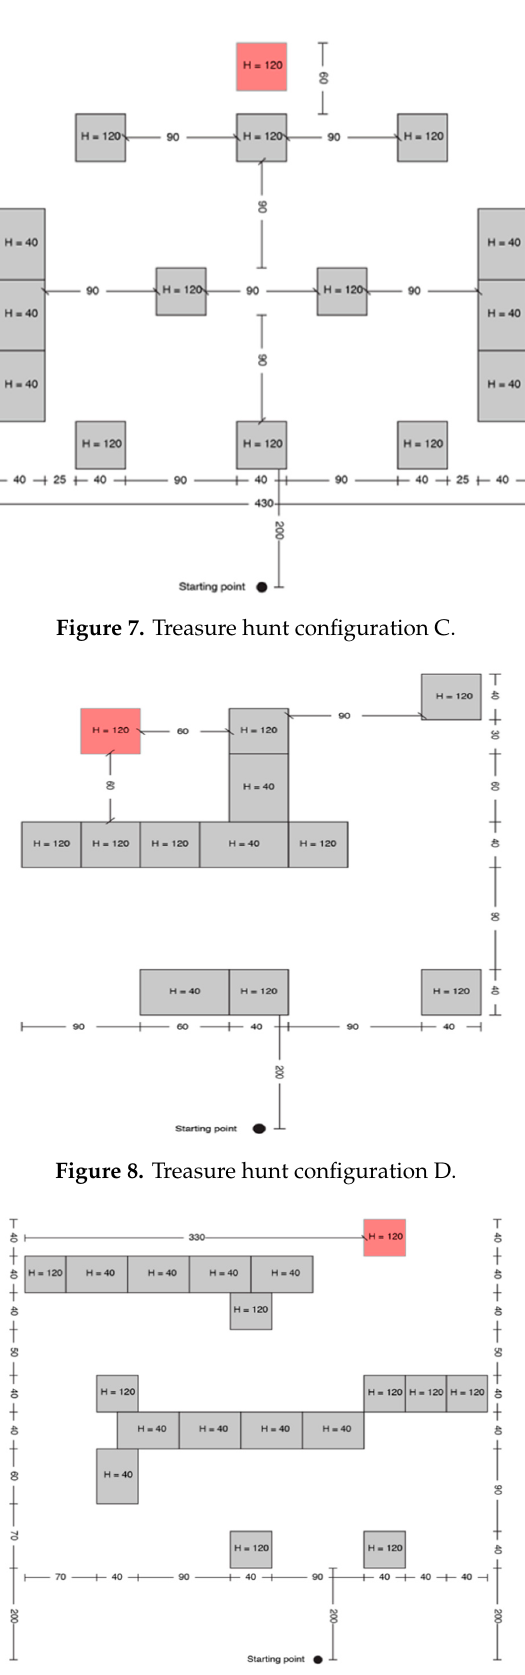
Figure 9. Treasure hunt configuration E.